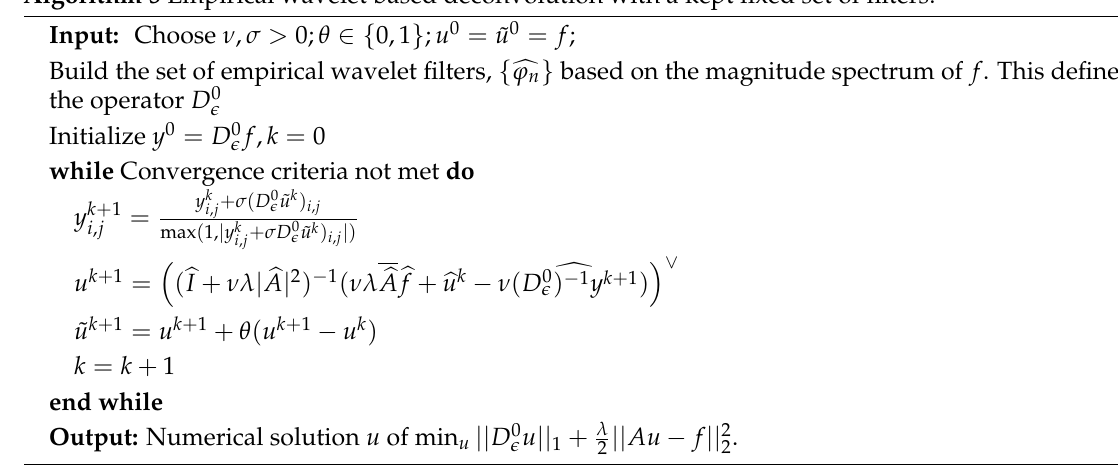
Algorithm 5 Empirical wavelet based deconvolution with a kept fixed set of filters.